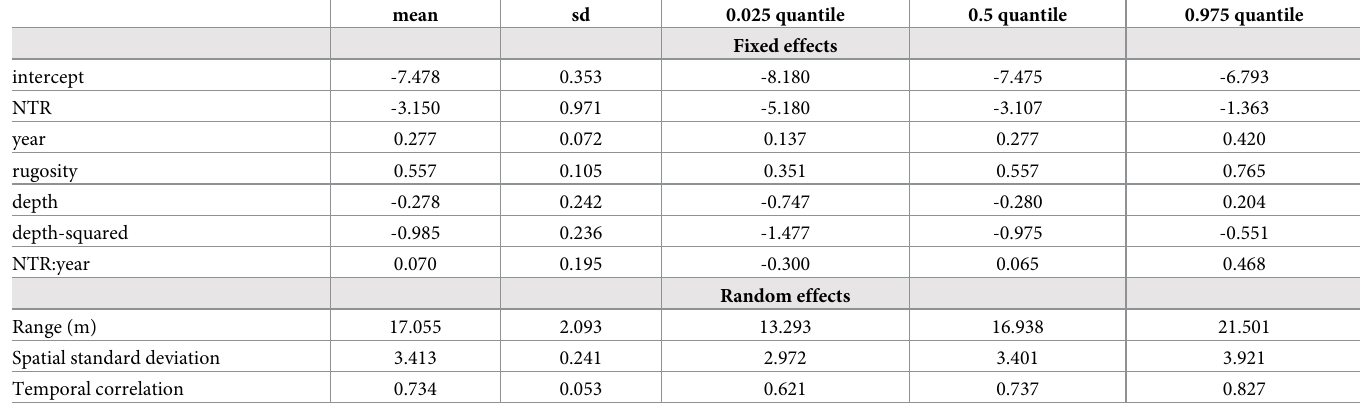
Table 1. INLA model posterior summary for fixed and random effects for the full spatio-temporal model ( M 3